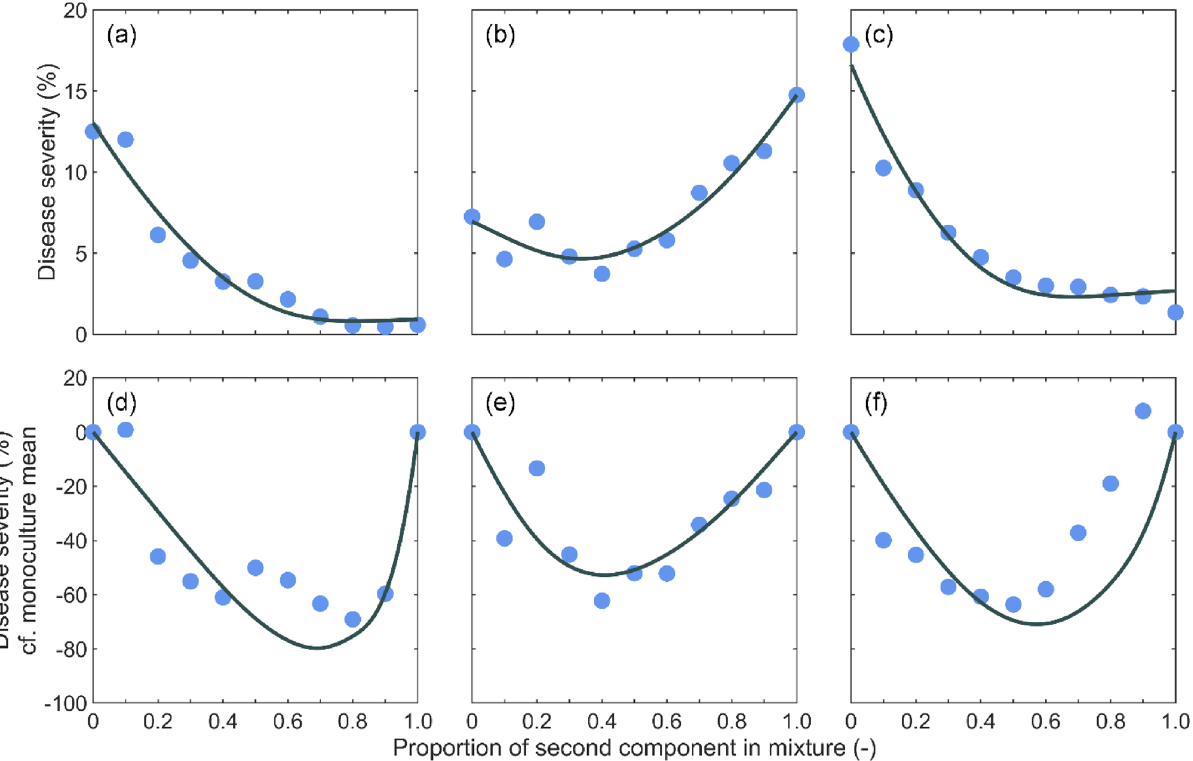
Figure 3. Rhynchosporium disease severity in 2-component barley mixtures. Panels show observed (markers) and predicted (lines) disease severity for ( a ) Optic-Westminster, ( b ) Concerto-Quench, and ( c ) Optic-Waggon, and observed and predicted mixture performance for ( d ) Optic-Westminster, ( e ) Concerto-Quench, and ( f )